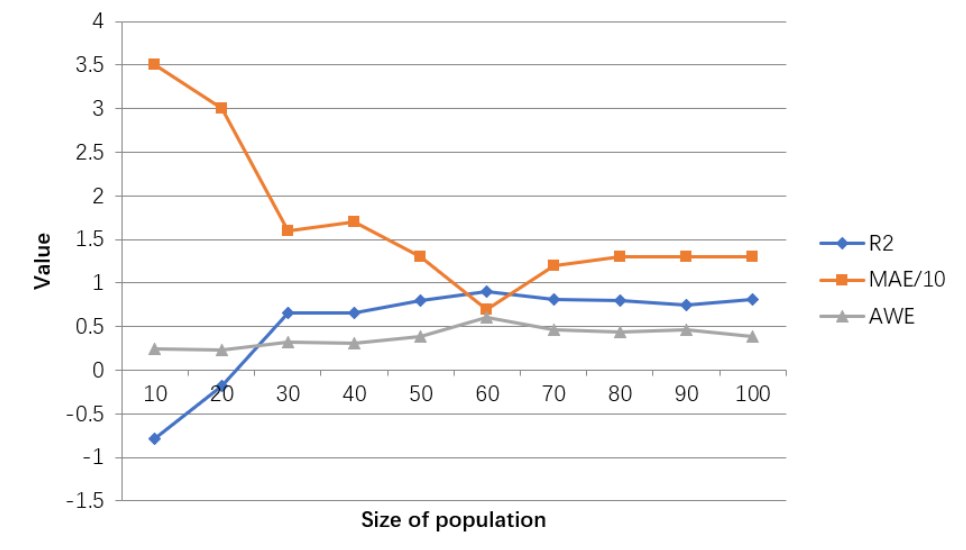
Figure 14. Line chart of adjustment results of hyperparameters in GA-BP model. The value represents results for R2, MAE/10, AWE for different parameters settings.